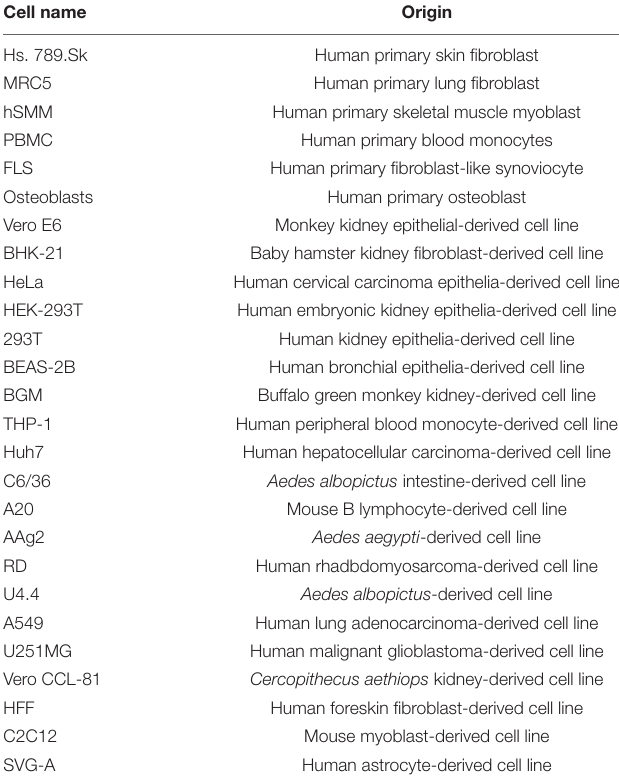
TABLE 2 | Summary of primary and immortalized cell lines used in CHIKV